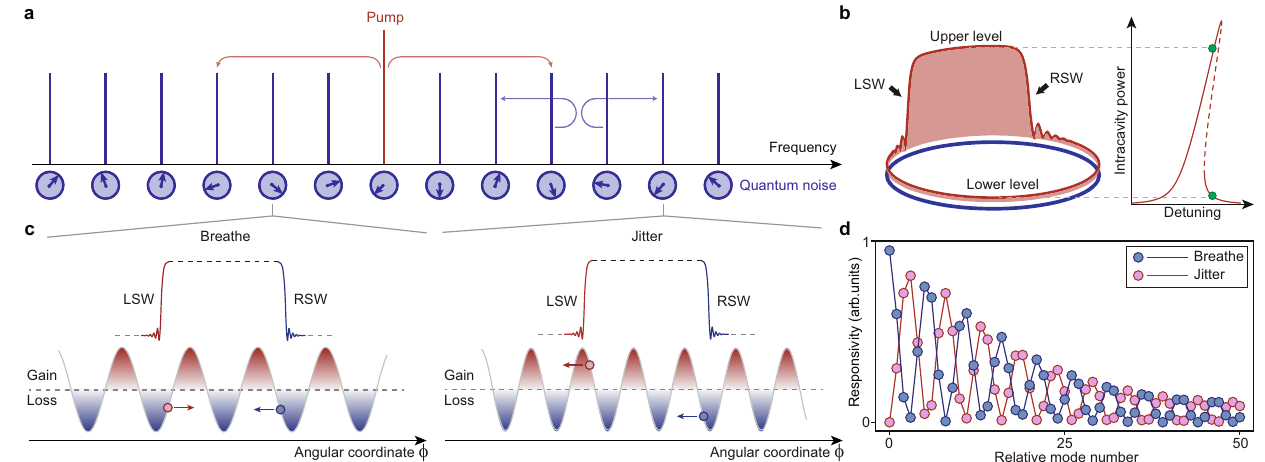
Angular coordinate (cid:2)